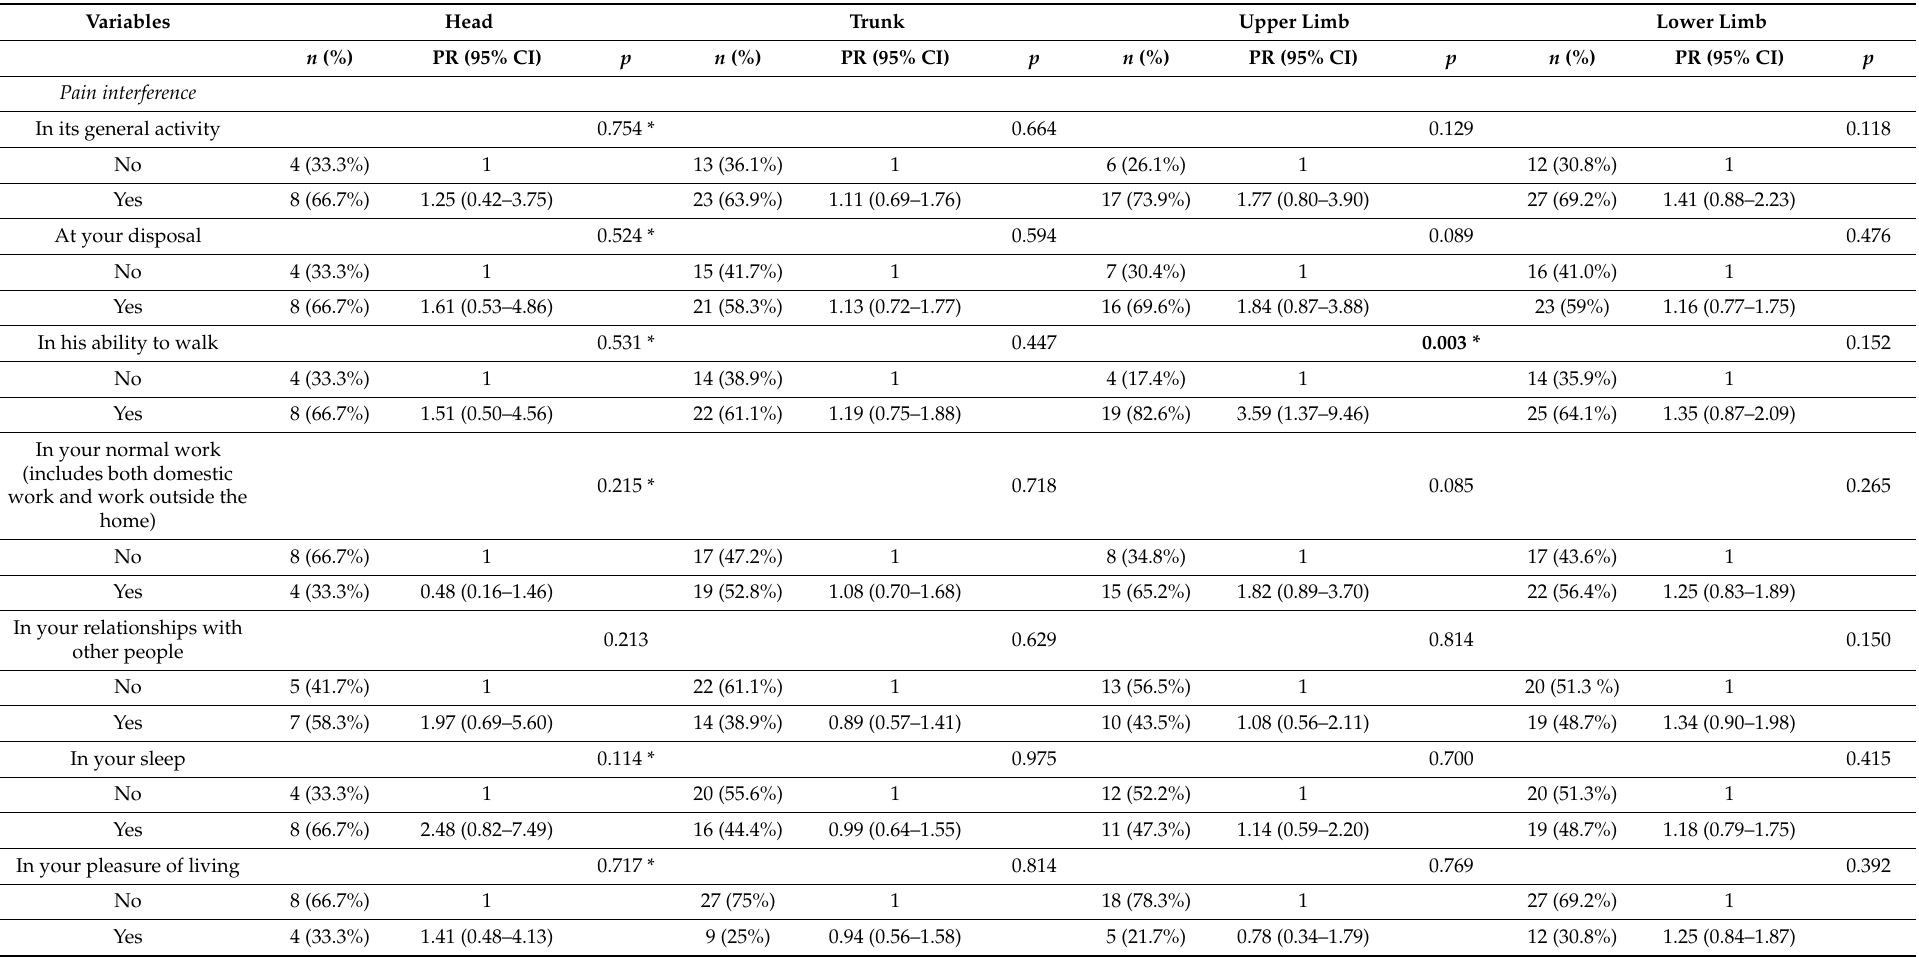
Table 3. Prevalence and Poisson regression analysis of the association of pain sites with severe pain interference in activities of daily living ( n =